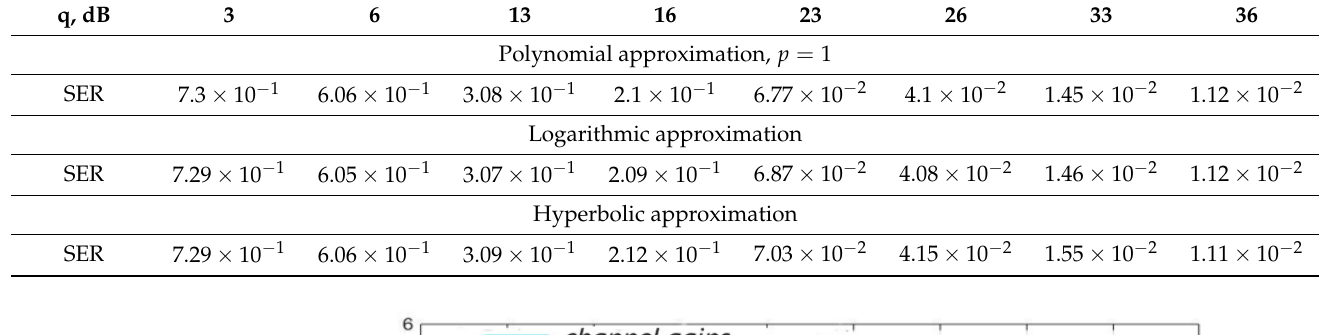
Table 8. SER of 64-QAM versus SNR per bit for m = 50, n 1 = 20, K 0 = 1.